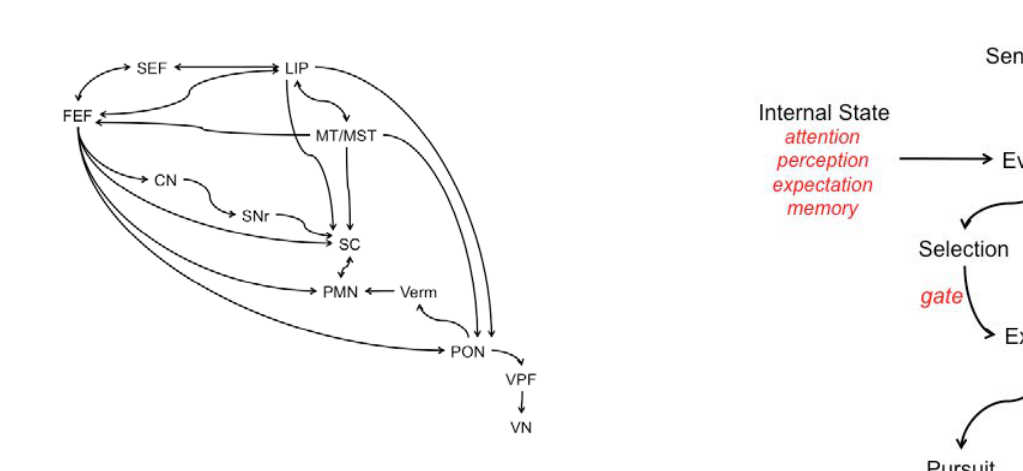
Figure 1. Schematic of the descending neural pathways thought to play a role for pursuit and saccadic eye move- ments (following Krauzlis 2005). Connections are not al- ways direct anatomical connections. Abbreviations: CN = caudate nucleus (basal ganglia); FEF = frontal eye field; LIP = lateral intraparietal area; MT = middle temporal area; MST = medial superior temporal area; PMN = brain stem premotor nuclei (PPRF, riMLF, cMRF); PON = pre- cerebellar pontine nuclei; SC = superior colliculus (inter- mediate and deep layers); SEF = supplementary eye field; SNr = substantia nigra pars reticulate; Verm = oculomo- tor vermis (cerebellum, lobules VI and VII); VN = vestibu- lar nuclei; VPF = ventral paraflocculus (cerebellum).